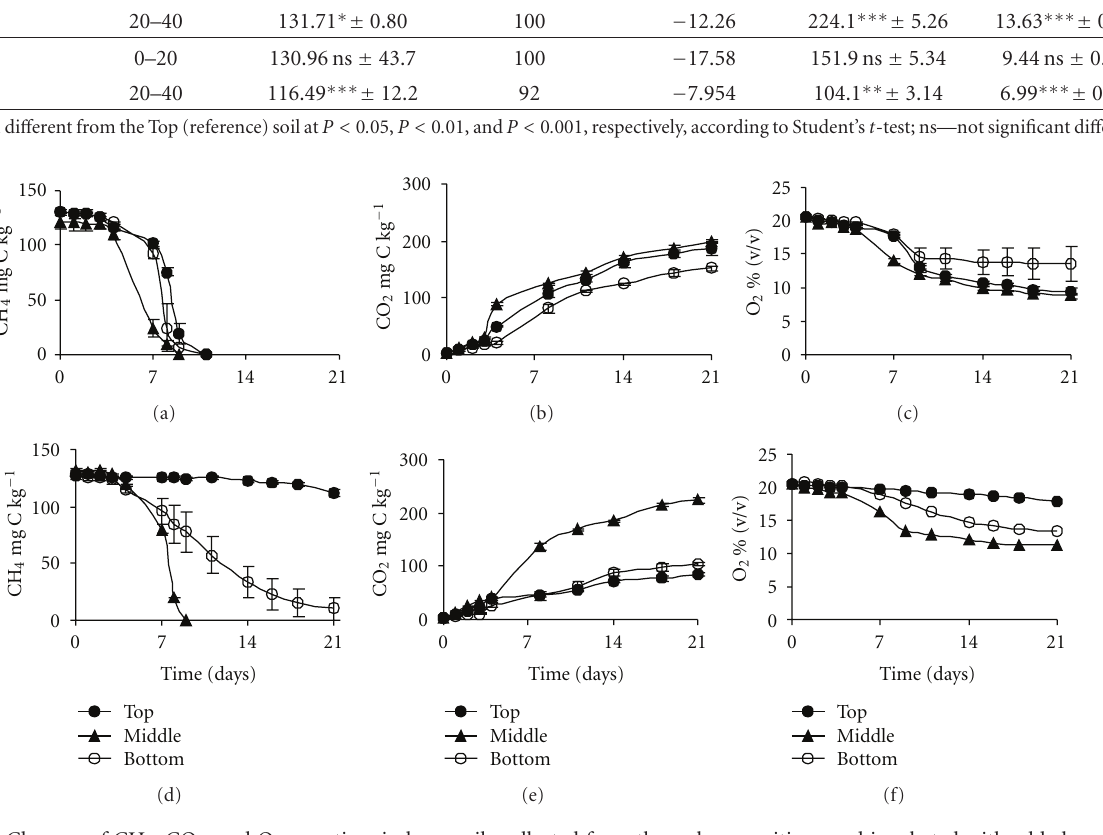
potential for CH 4 production and oxidation and modified soil respiration involved in CH 4